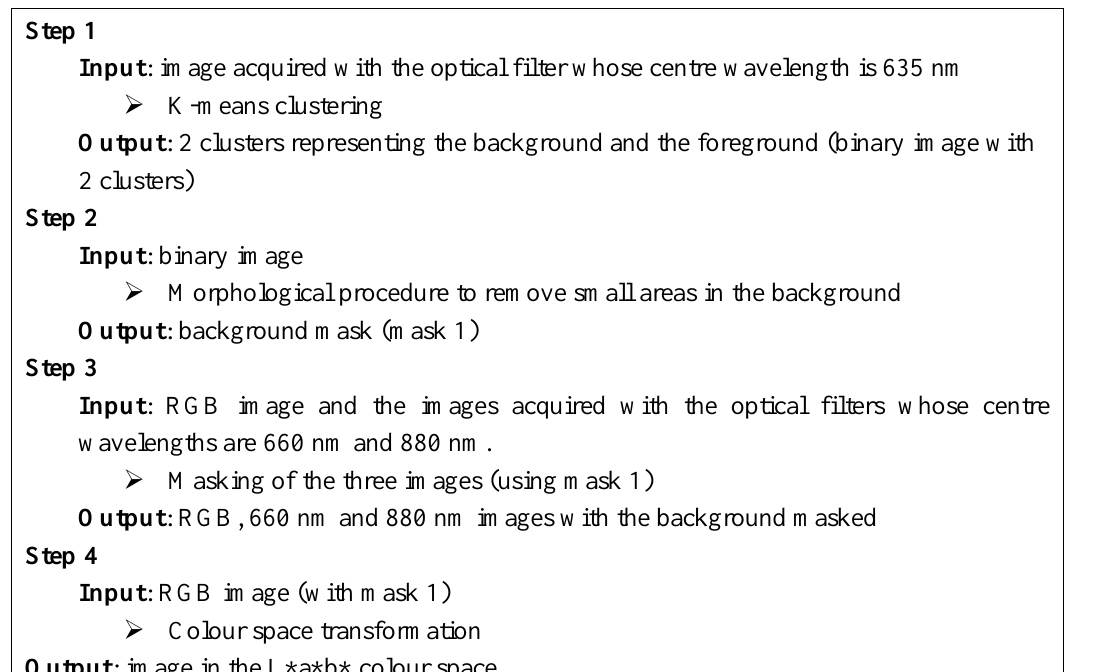
Table 1. Summary of the proposed